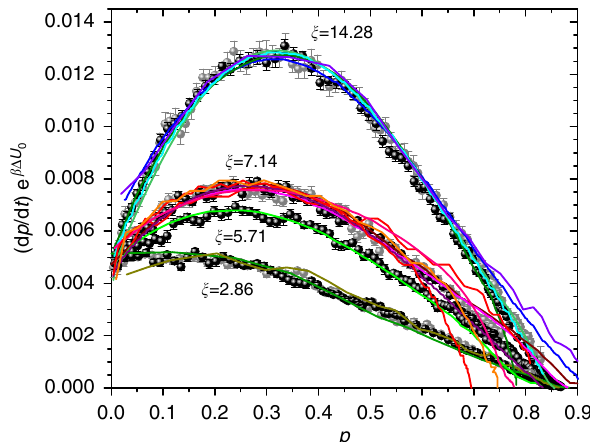
Fig. 7 Qualitative comparison with experimental data. Symbols: reaction rate scaled by e (cid:2) β Δ U 0 obtained from simulation Colored lines: experimental data for stoichiometric formulations of epoxy – amine resins, scaled by an arbitrary factor. Discrepancy in the high p region depends on the different p dependence of the diffusion coef fi cient in experimental reality with respect to the simulation